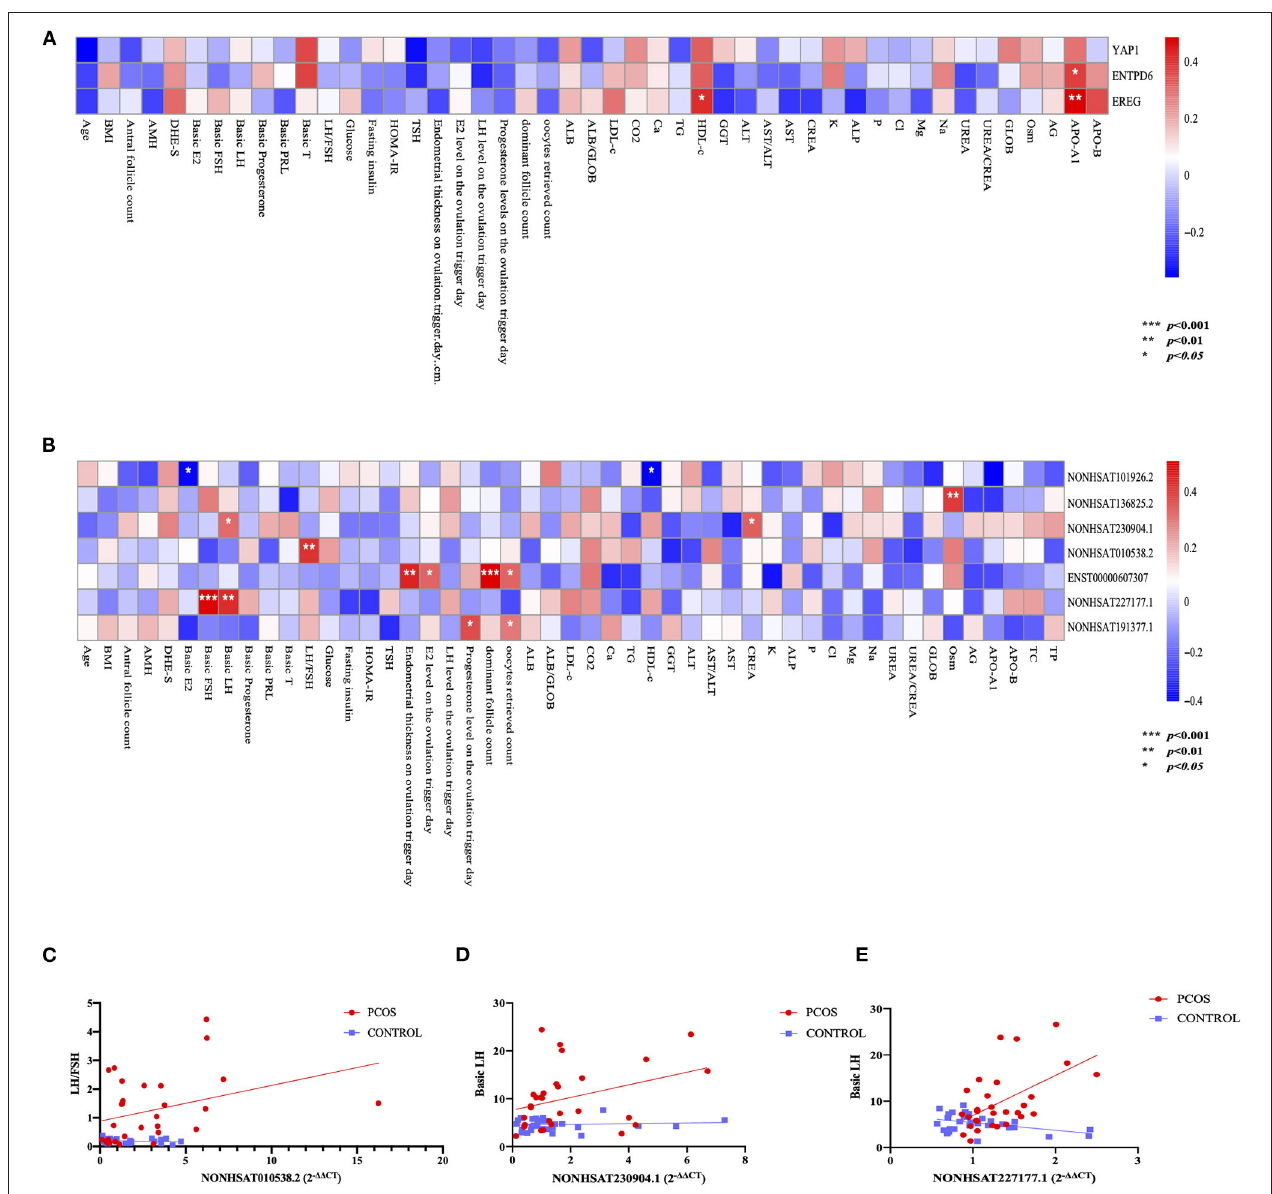
FIGURE 3 | Correlation between polycystic ovary syndrome (PCOS) phenotypes and long non-coding RNAs (lncRNAs). (A) Binary correlation analysis between 3 mRNAs and PCOS phenotypes. (B) Binary correlation analysis between 7 lncRNAs and PCOS phenotypes. (C) Scatter diagram and linear correlation analysis of luteinizing hormone (LH)/follicle-stimulating hormone (FSH) ratio and NONHSAT010538.2 ( r = 0.4905, p = 0.0059). (D) Scatter diagram and linear correlation analysis of basic luteinizing hormone (LH) level and NONHSAT230904.1 ( r = 0.3813, p = 0.0412). (E) Scatter diagram and linear correlation analysis of basic luteinizing hormone (LH) level and NONHSAT227177.1 ( r = 0.5046, p =